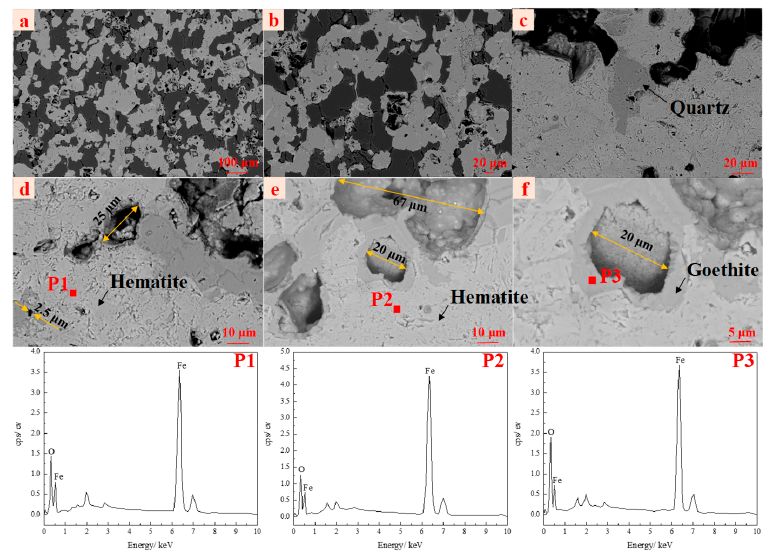
Figure 1. Microstructure and EDS results of #1 iron ore. ( a ) Microstructure image with 100 μ m scale; ( b ) Microstructure image with 20 μ m scale; ( c ) Microstructure image with 20 μ m scale; ( d ) Pore structure with 10 μ m scale; ( e ) Pore structure with 10 μ m scale; ( f ) Pore structure with 5 μ m scale; ( P1 ) EDS results for hematite in (d); ( P2 ) EDS results for hematite in (e); ( P3 ) EDS results for goethite in (f).